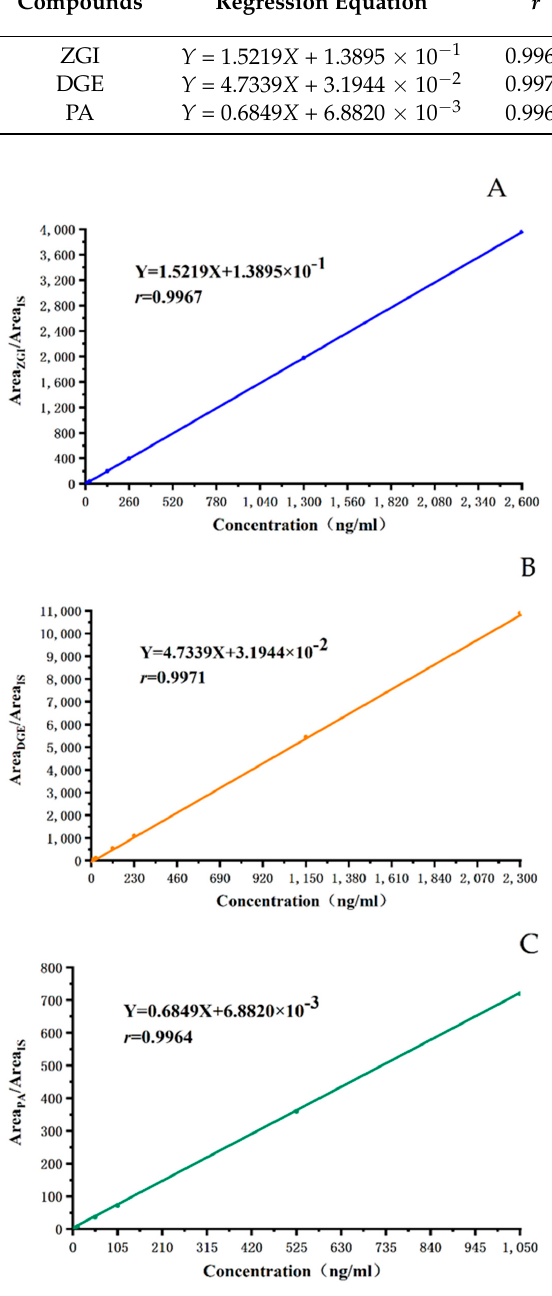
Figure 2. The calibration curves of ZGI, DGE, PA. ( A ) The calibration curves of ZGI ( B ) The calibration curves of DGE. ( C ) The calibration curves of PA.